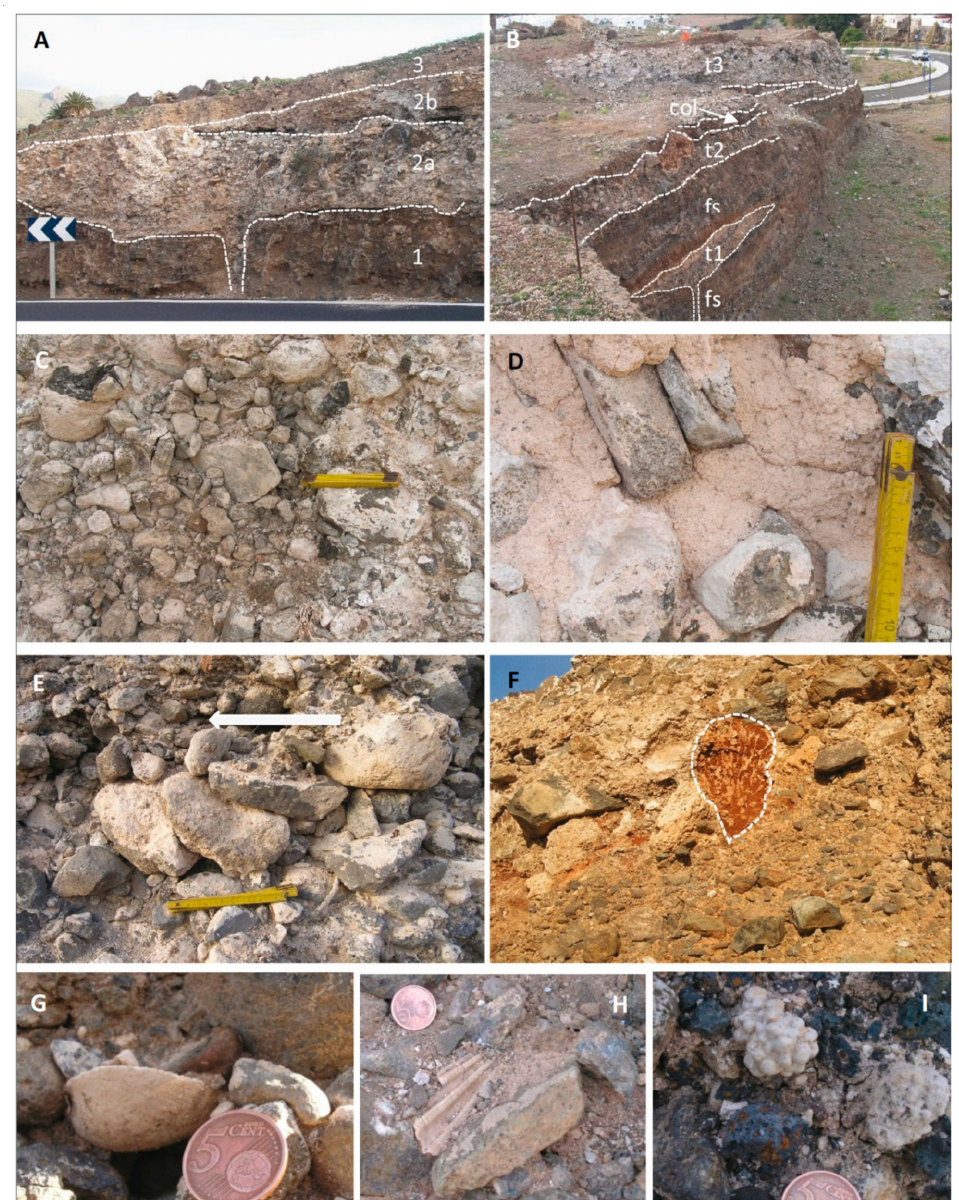
Figure 11. Tsunami deposits in the Agaete valley: ( A ) general aspect of La Aldea outcrop; the tsunami deposit, overlying a pedogenized colluvium (1), is formed by a basal coarse reverse graded layer (2a) and a finer upper layer (2b), and is covered by a sandy colluvium containing pulmonate gastropods (3); note a downward injected clastic dyke in the center of the photo. ( B ) General view of La Ruina outcrop displaying three superposed tsunami deposits (t1, t2, and t3); the upper tsunami deposits are separated by a brown pedogenized colluvium (col) and the lower tsunami deposit is lenticular and is intercalated within a fluvial sequence (fs) of mudflow and stream-flow deposits; note the presence of a downward injected clastic dyke in the center of t1. ( C ) Aspect of the clast supported texture of the upper layer of the tsunami deposit at La Aldea outcrop. ( D ) Matrix supported texture of t3 tsunami deposit at La Ruina outcrop; the white sandy matrix is intensely calcretized. ( E ) Landwards imbricated flat clasts at La Aldea outcrop. ( F ) Large (~60 cm vertical axis) rip-up clast of red pedogenized basaltic tuff from the underlying volcanic sequence in the lower tsunami deposit at Llanos de Turman. ( G – I ) Examples of the fossiliferous content of the lower tsunami deposit at Llanos de Turman outcrop ( Glycymeris , pecten fragment, and rhodolith). Yellow measuring tape in photos C, D, and E is 20